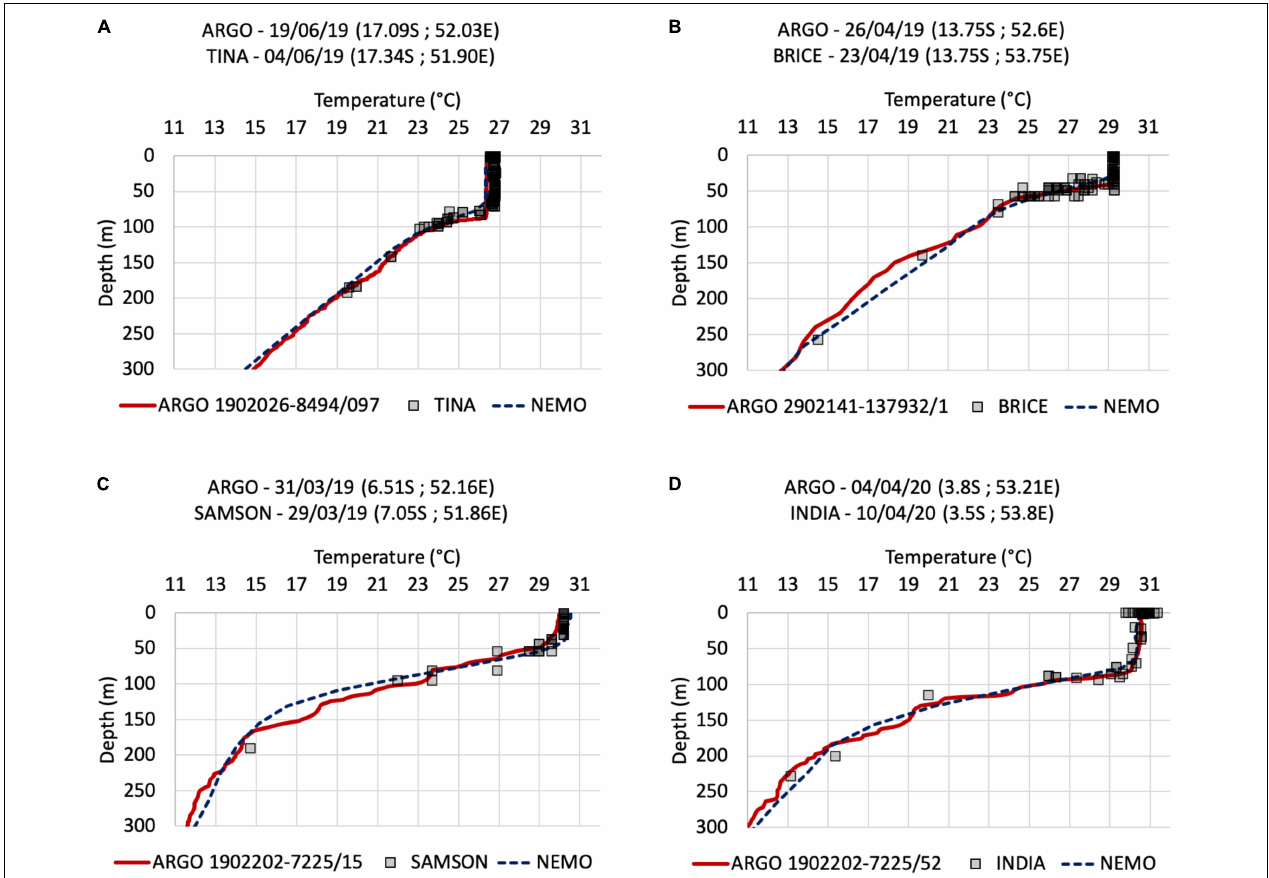
FIGURE 6 | Comparison of various ST-borne (square), ARGO (red) and Glo12 (blue dotted) temperature profiles in the SWIO basin on (A) 19 June 2019, (B) 26 April 2019, (C) 31 March 2019 and (D) 4 April 2020 (see details at the top and bottom of each sub-panel for information on the date, reference and location of the profiles). Temperature profiles derived from ARGO and Glo12 are both spatially and temporally localized, while ST profiles consist of aggregated temperature measurements over a 12–18-h period at the nearest ARGO positions within a 3–14-day